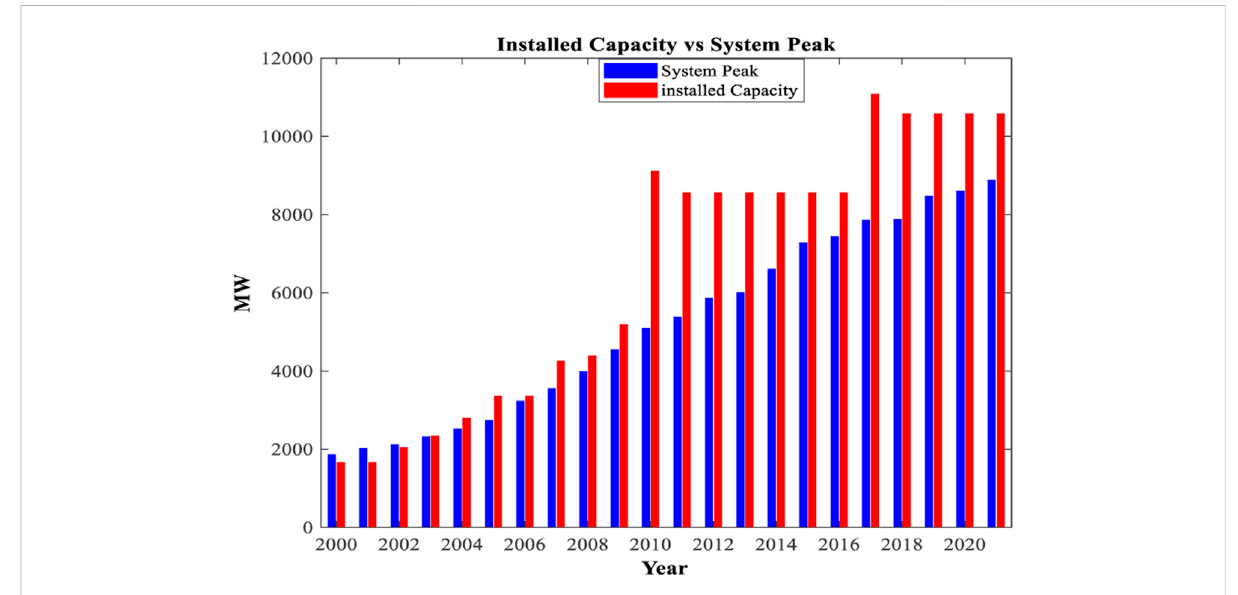
FIGURE 6 The installed capacity and system peak from 2000 up to